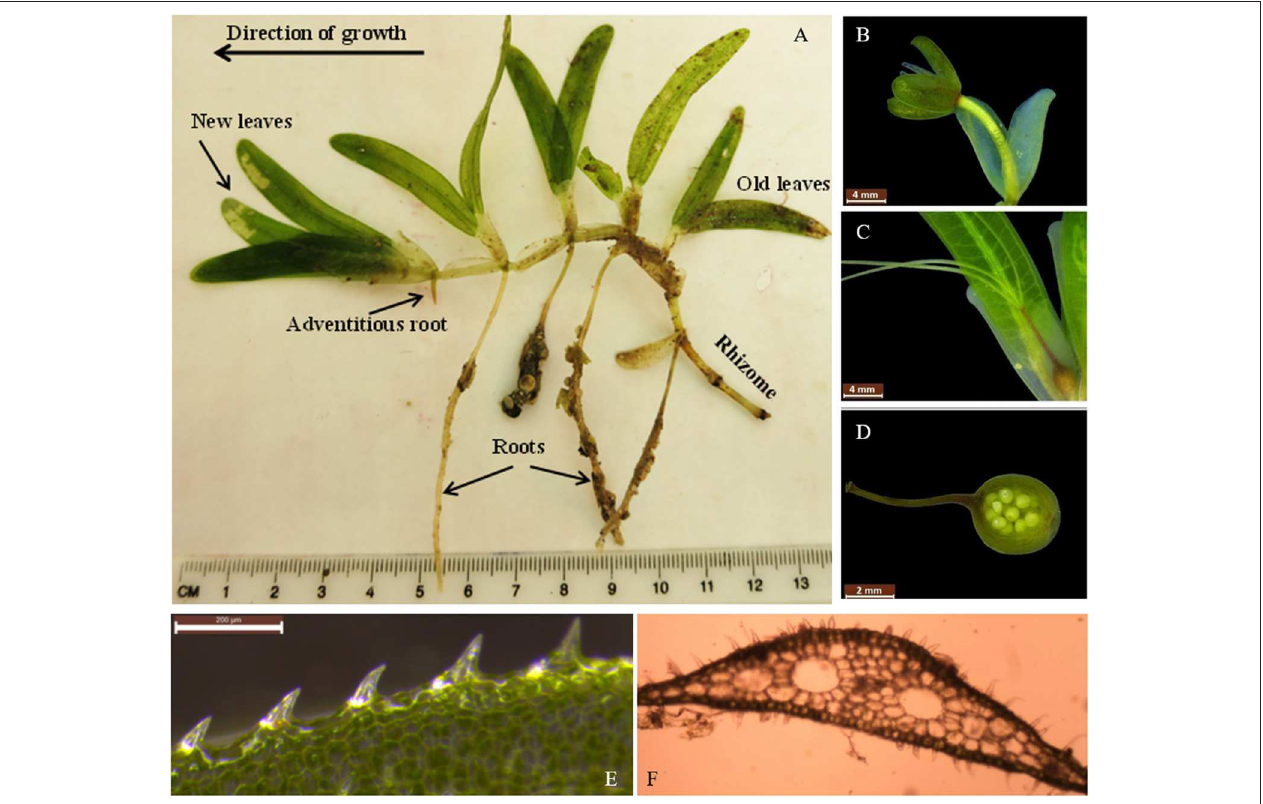
FIGURE 2 | Characteristic morphology of the tropical seagrass Halophila stipulacea . (A) Shown are rhizomes (smooth with long internodes and leaf scars at stem base), roots (covered by small hairs, could be sand-or gravel-binding), and shoots (each carrying two linear leaf blades that contain mid and branched veins). (B-D) Flowers and fruits of H. stipulacea : shown are mature male (B) and female (C) flowers, alongside seeds within a cut fruit (D). Magnification (x10) showing that leaf margin is serrated (E) and minute trichomes may be present on one side of the leaf surface (F) . Photos were taken by Gidon Winters (A,E,F) and Hung Manh Nguyen (B–D) . (C) and (D) were adapted from Nguyen et al., 2018. All photos in this figure have been obtained with permission from the original copyright